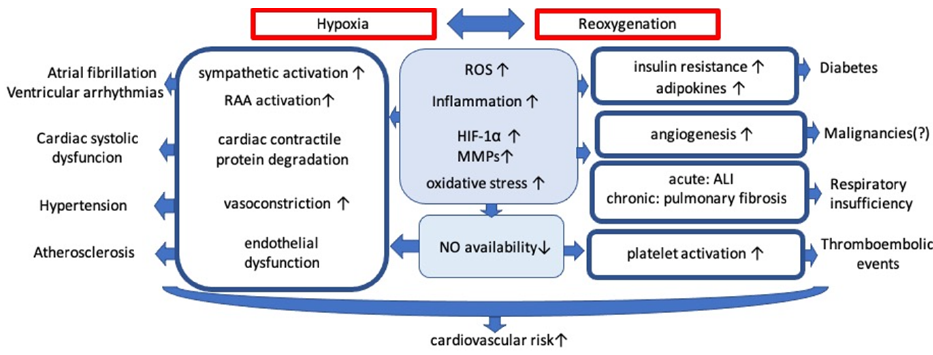
Figure 1. Mechanisms contributing to the progression of cardiovascular disorders. Abbreviations: ROS: reactive oxygen species; HIF-1 α : hypoxia inducible factor 1 α ; MMPs: matrix metalloproteinases; ALI: acute lung injury; RAA: renin-angiotensin-aldosterone; NO: nitric oxide; ↑ : increased; ↓ : decreased.